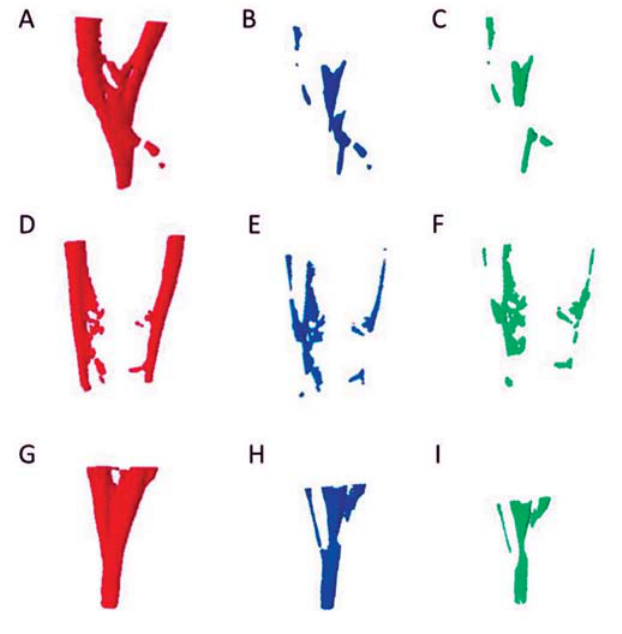
Figure 1- A, B and C represent specimens from the Conventional group; D, E and F from the PUI/NaOCl group;